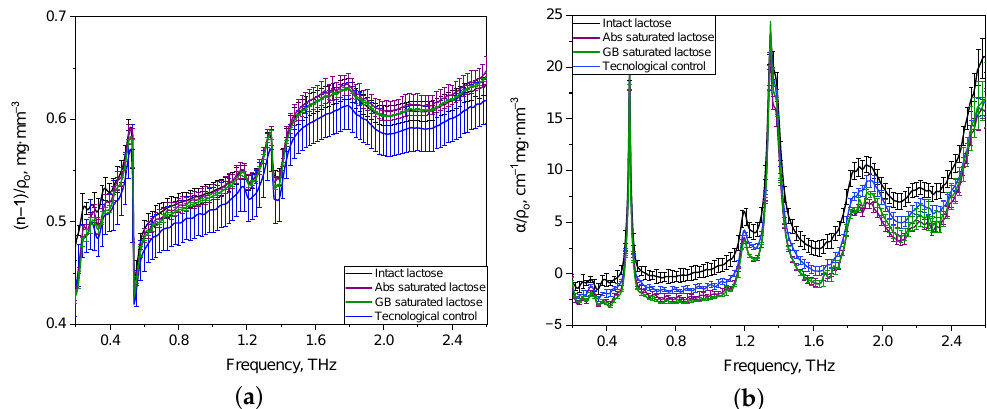
Figure 3. Averaged and density-normalized spectra of refractive index ( a ) and absorption coefficient ( b ) of thin lactose tablets in the THz frequency